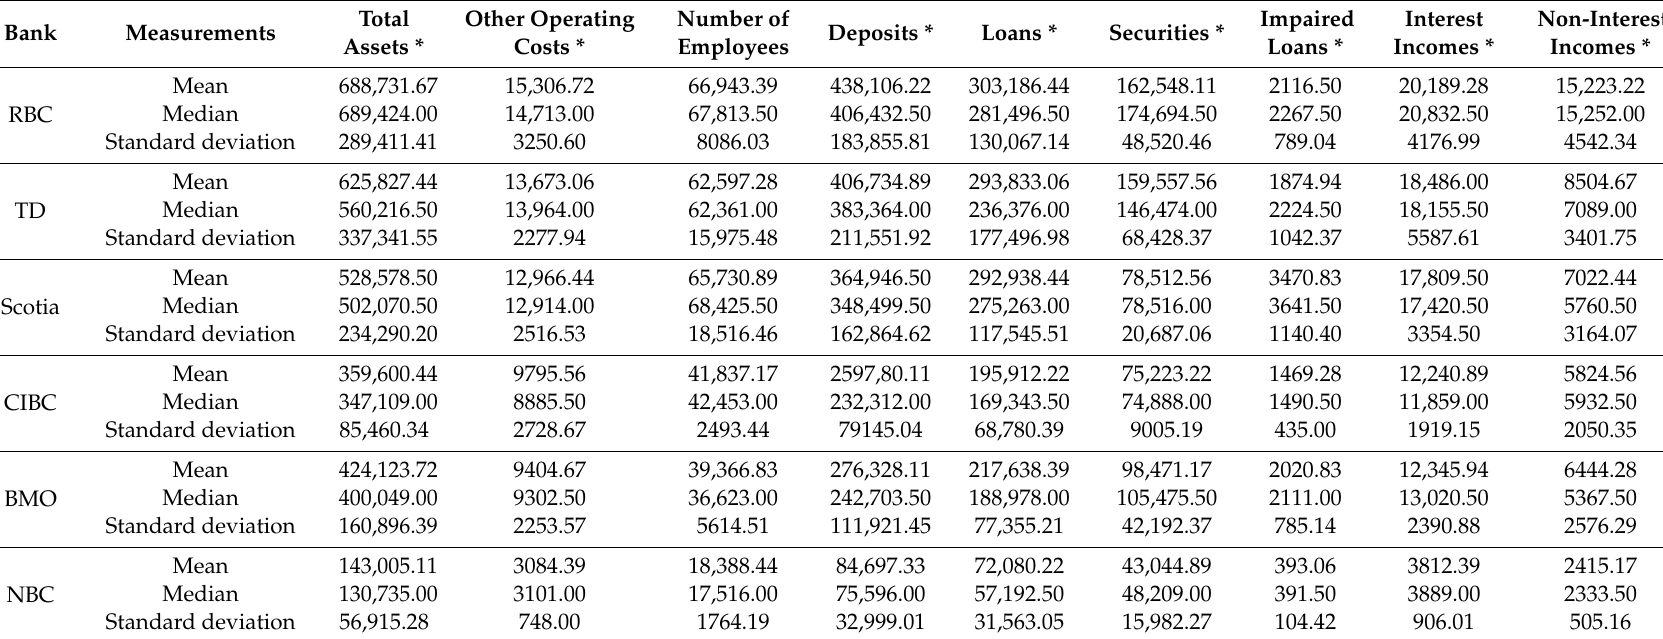
Table 1. Descriptive analysis—Inputs and outputs for the banks for the period